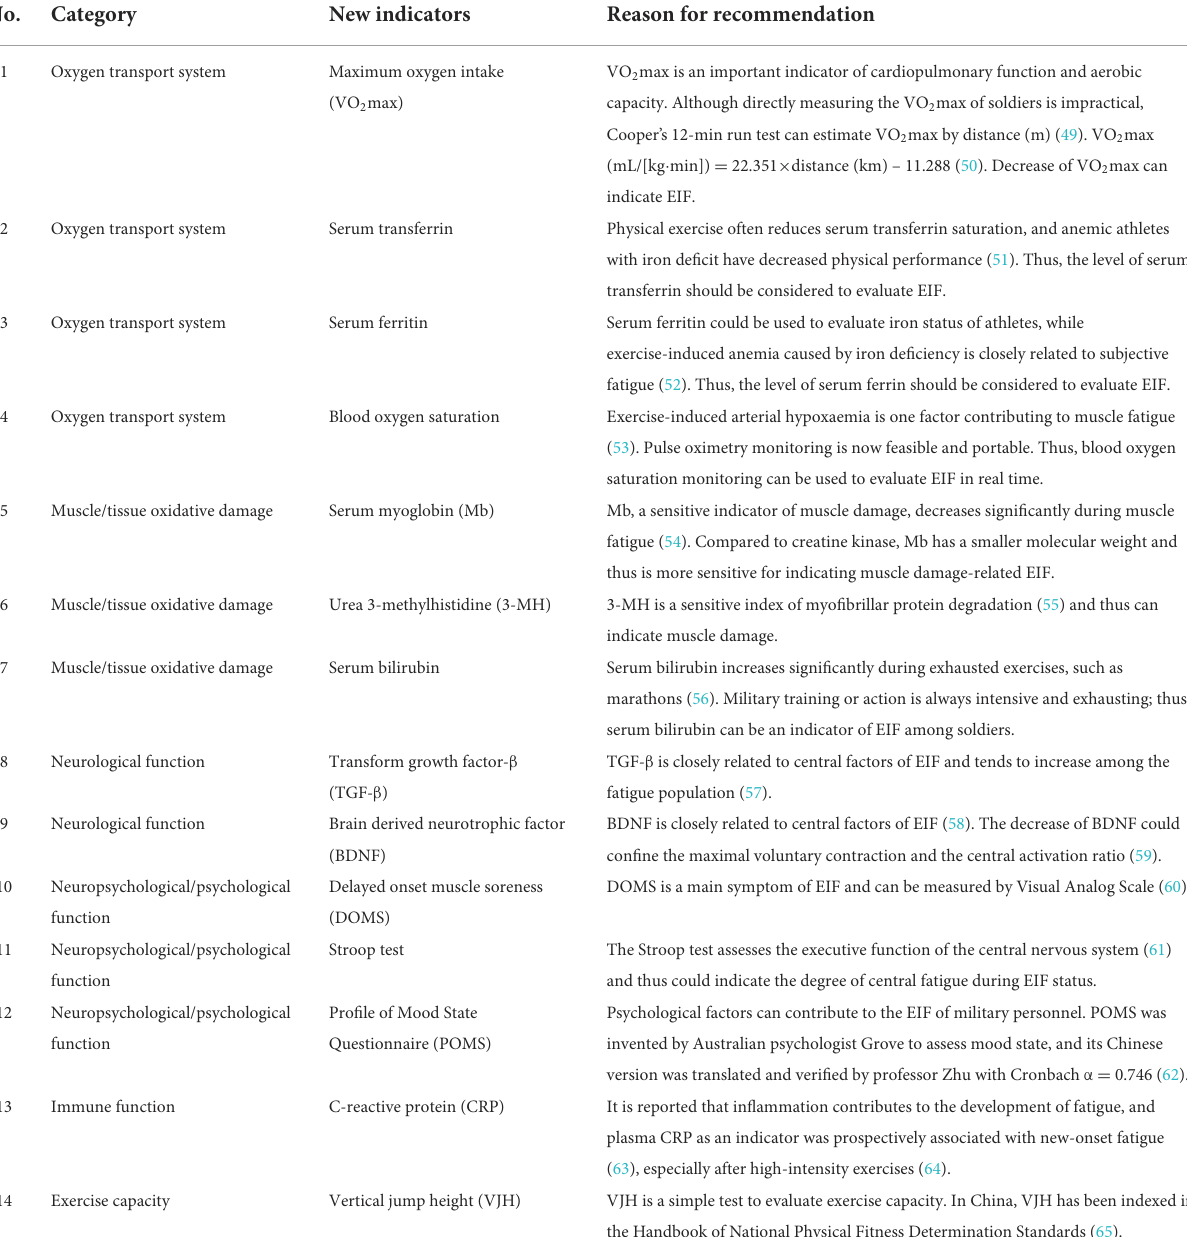
TABLE 5 New indicators put forward by experts in round 2.